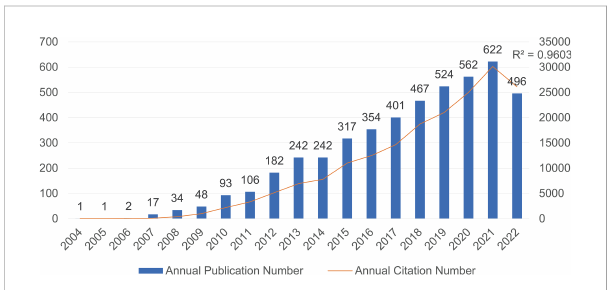
FIGURE 1 The number of annual publications and citations of IL-33 research from 2004 to 2022 has been steadily